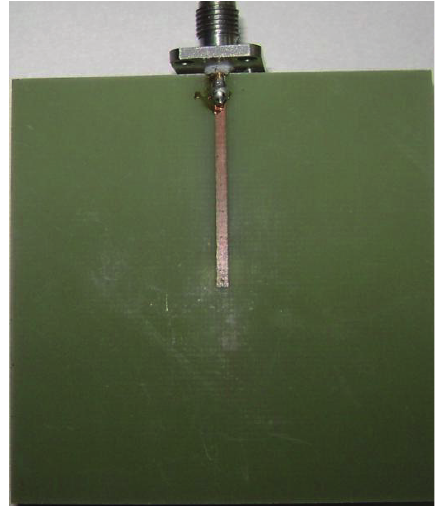
Figure 5: Aperture